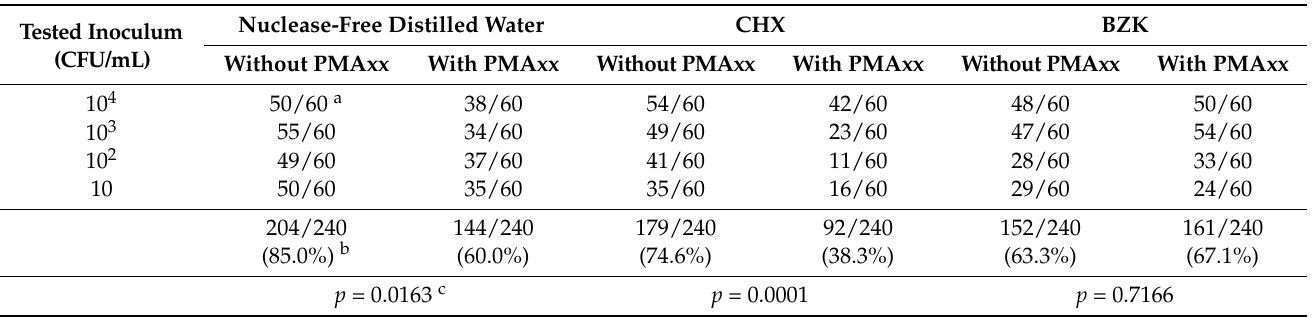
Table 2. Estimated sensitivity analysis of the PMAxx- ddPCR assay from BCC cultured from nuclease- free distilled water, CHX, and